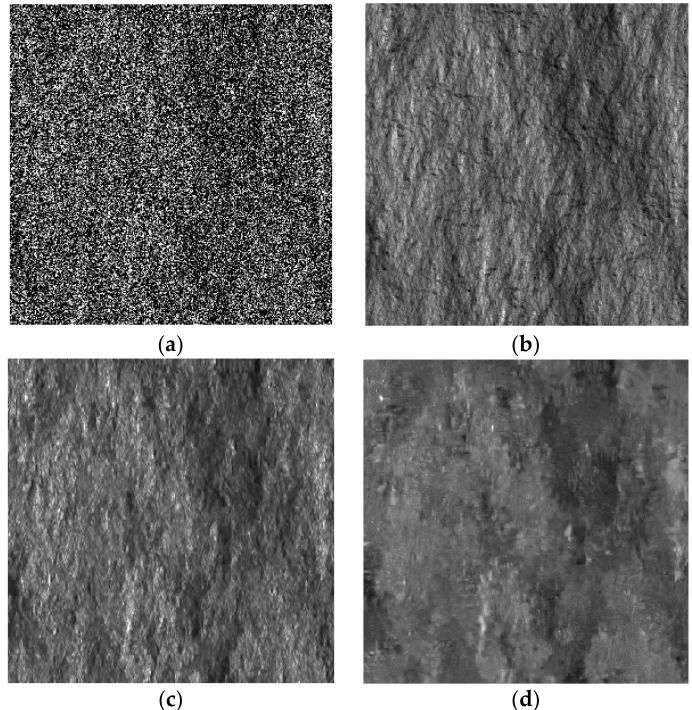
Figure 4. Simulated and despeckled SAR images relevant to the DEM in Figure 2a and assuming the cos 2 ϑ scattering model. ( a ) Noisy; ( b ) reference SAR image; ( c ) SB-SARBM3D; ( d ) SARBM3D.